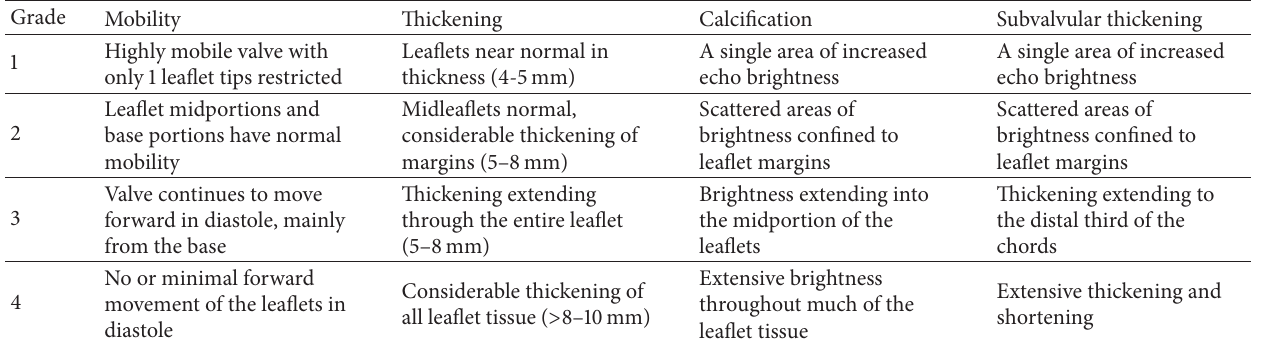
Table 1: Grading of mitral valve characteristics according to Wilkins score.